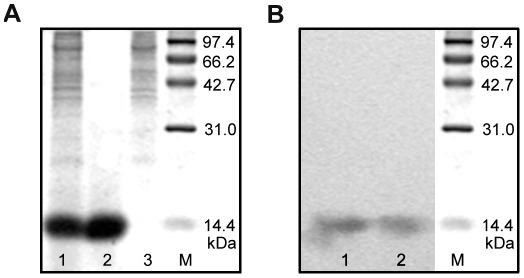
Recombinant NGR-hPK5 protein purification and identification.
A
, Expressed and purified NGR-hPK5 samples were separated by Tricine-SDS-PAGE, M: molecular weight markers. The culture supernatant was collected and concentrated using ammonium sulfate precipitation (70%), dissolved in buffer A (lane 1). After the ion exchange purification by DEAE-Sepharose Fast Flow column, NGR-hPK5 was eluted with 0.1 M NaCl in buffer B (lane 2), whereas the bulk impurities were eluted with 0.5 M NaCl in buffer B (lane 3). B
, Western blot analysis of hPK5 (lane 1) and NGR-hPK5 (lane 2) proteins using anti-human plasminogen antibody.